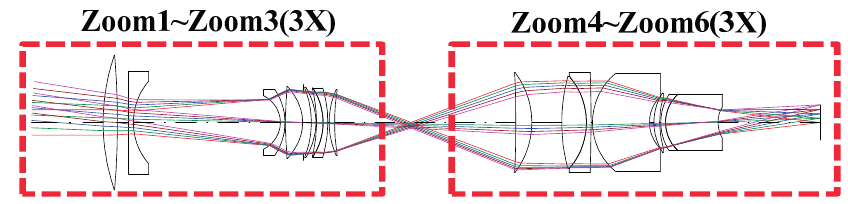
Figure 2. The structure of 9× zoom lens with intermediate optics image (The 3X means 3X optical